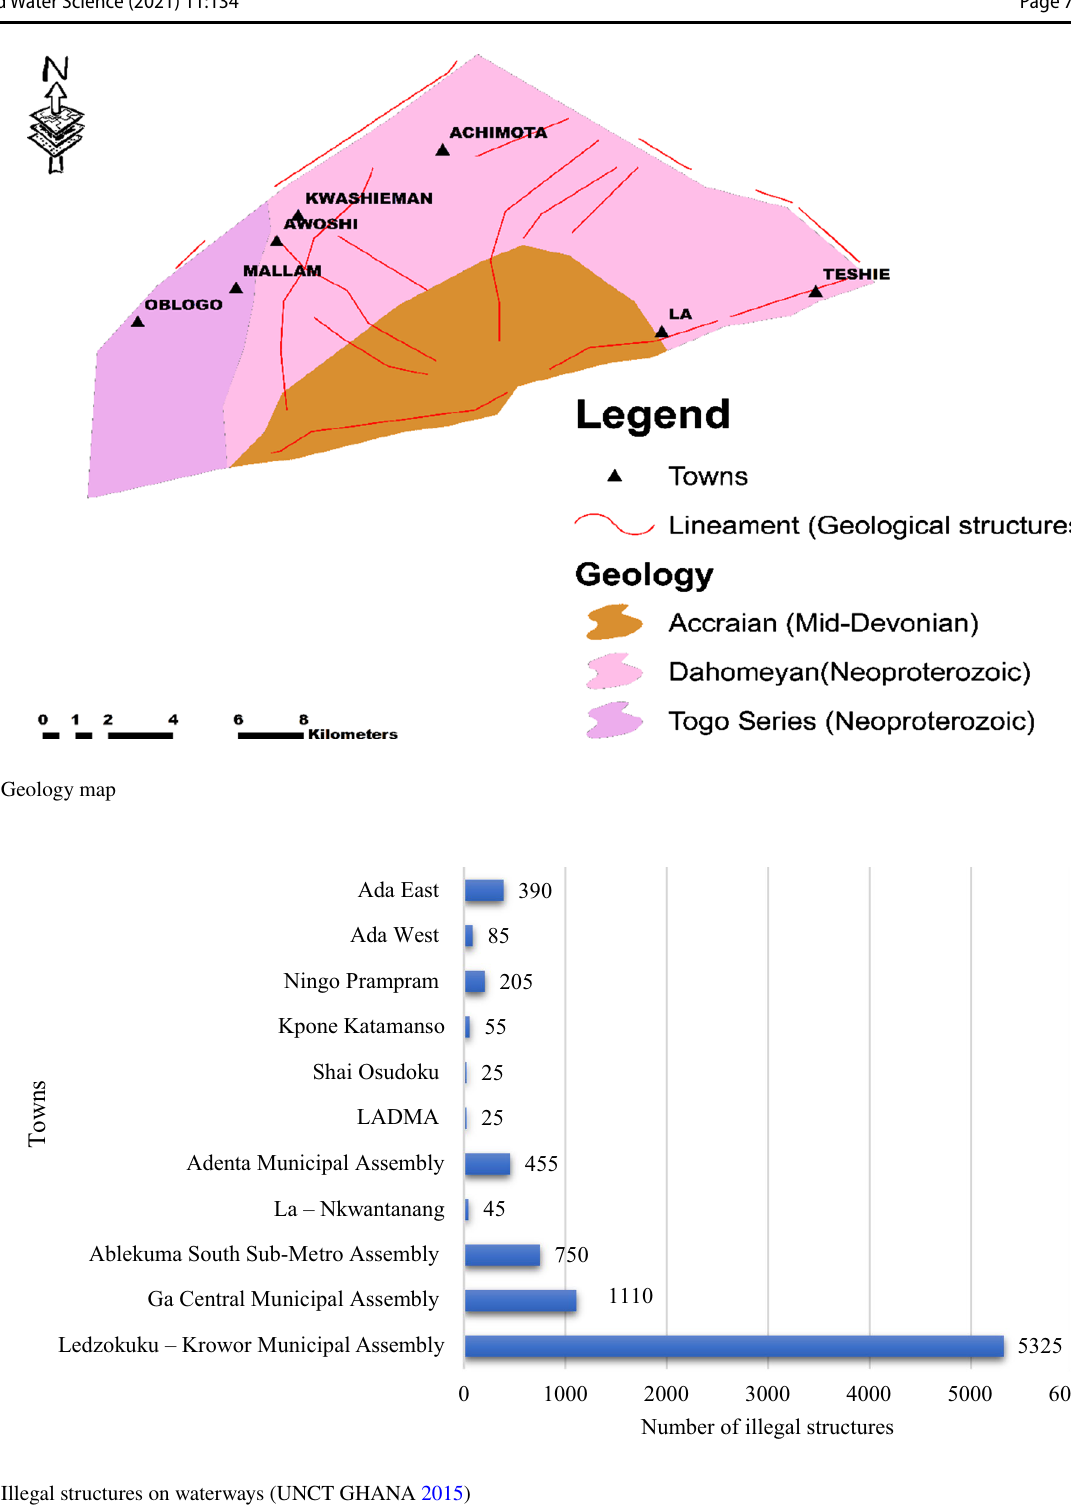
Fig. 6 Illegal structures on waterways (UNCT GHANA